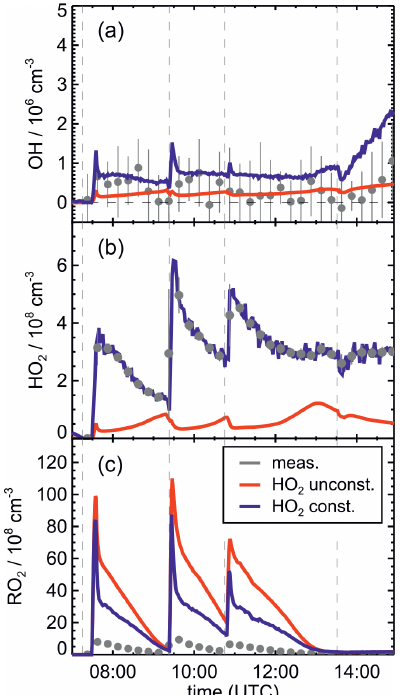
Figure 8. Comparison of results from model calculations apply- ing the FZJ-NO3 mechanism for the experiment on 13 August 2018 (Experiment 4) with HO 2 concentrations being either con- strained (const.) or unconstrained (unconst.) to measurements. A large fraction of OH is produced from the reaction of HO 2 with NO 3 , so lower-than-measured HO 2 concentrations in the uncon- strained model run lead to low OH concentrations. Because HO 2 + RO 2 reactions contribute significantly to the total loss of RO 2 , modelled RO 2 concentrations are higher in the unconstrained model run. RO 2 measurements by the LIF instrument do not include all RO 2 radicals (Vereecken et al., 2021), so measured concentrations are lower than modelled